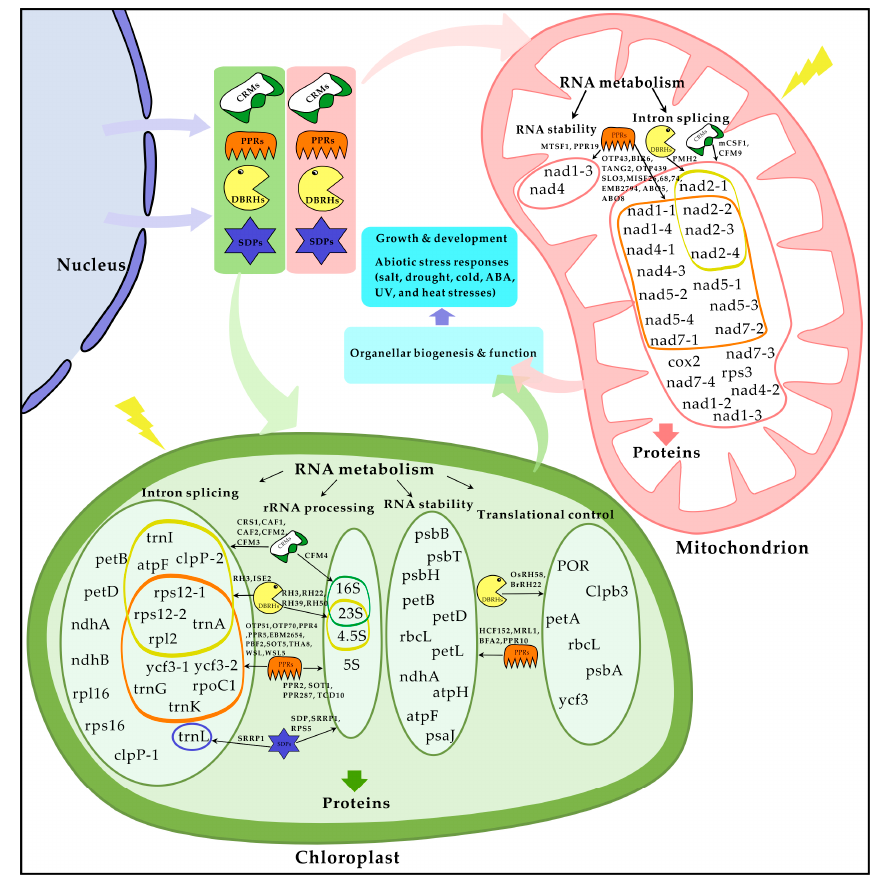
Figure 2. Cellular function of nucleus-encoded Chloroplast or Mitochondrial RNA-Binding Proteins (nCMRBPs) in organellar RNA metabolism. Nucleus-encoded CRMs, PPRs, DBRHs, and SDPs are transported into chloroplasts and/or mitochondria and are involved in RNA metabolism, including intron splicing, RNA stability, rRNA processing, and translational control in organelles as described in Table 1 and Table 2. The nCMRBP-mediated RNA metabolism influences the homeostasis of organellar biogenesis and function, which plays an essential role in plant growth and development, as well as in abiotic stress responses. Yellow-colored thunder indicates environmental stimuli.